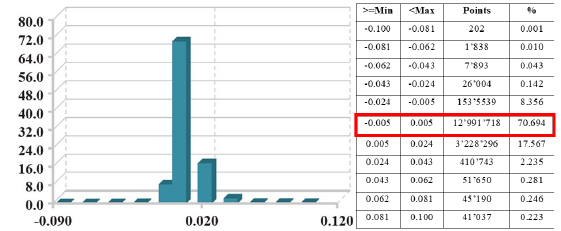
Figure 9: Graph and table indicating the distribution of